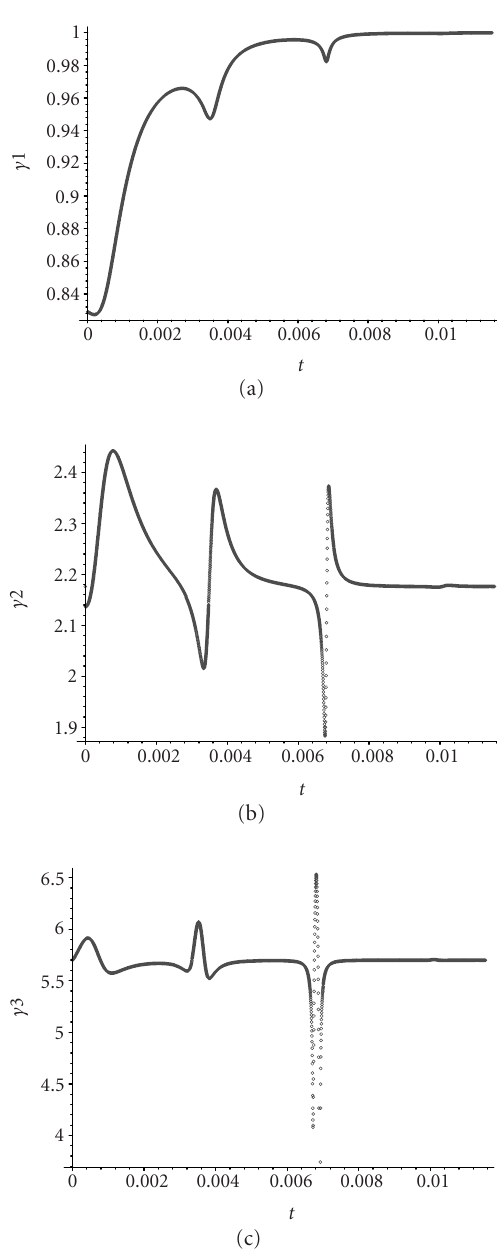
Figure 5.1. ε , ˙ ε , and ¨ ε as functions of τ . These are called γ 1, γ 2, and γ 3, respectively, on the figures. To make (b) and (c) convenient to represent, we have added 150 to the values of (b) and 5 × 10 3 to (c), assuring positivity (and value greater than unity) in our data range, and taken the logarithm base 10. Recursive, approximate quasiperiodic behavior is clearly visible in the variables ˙ ε , ¨ ε